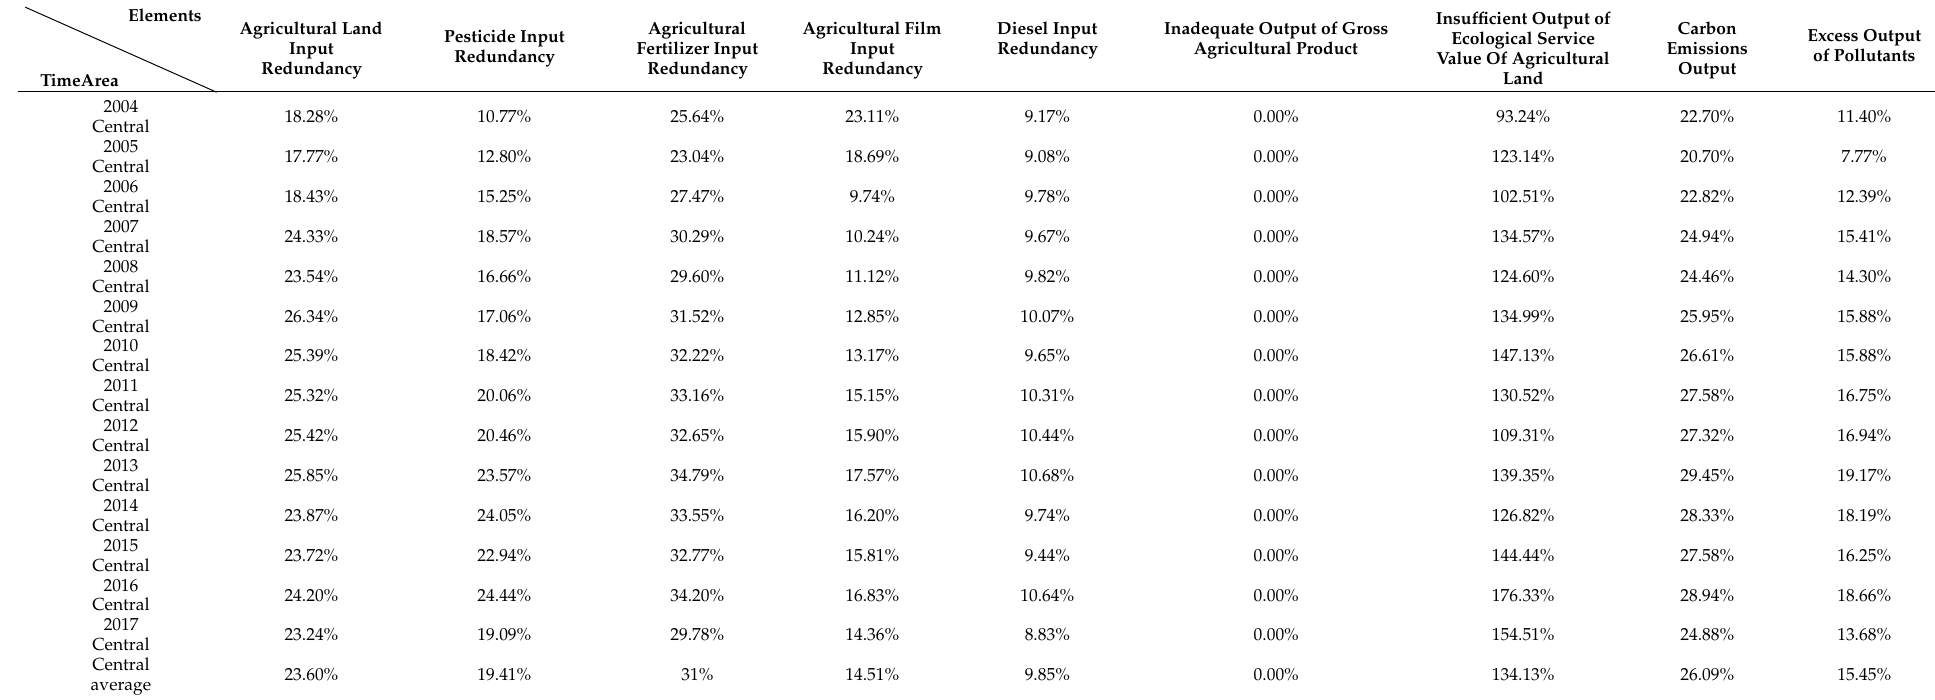
Table 5. Changes in input redundancy, desired output deficiency, and undesired output excess in the ecological use process of agricultural land in central